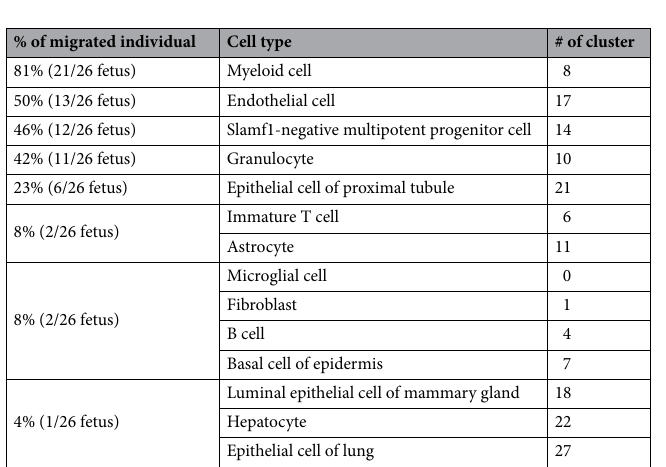
Figure 4. Estimation of MMc cell types. ( a ) Data for MMc cells from 26 embryos were combined (191 cells in total) and are shown as a pie-chart of the proportion of the estimated cell types. The numbers in brackets indicate cluster number after analysis using 11 PC set. ( b ) Pie-chart of the prevalence of the isolated MMc cells in three categories: immune-related cells, proliferating/stem cells, and terminally differentiated cells. ( c ) MMc cell type composition of each embryo, shown as pie-charts. Numbers in parentheses indicate the number of GFP-positive cells identified in each embryo. The color-coding is as in ( a ). Microsoft EXCEL (https:// www. micro soft. com, EXCEL for Mac ver. 16.62) was used to create the images.